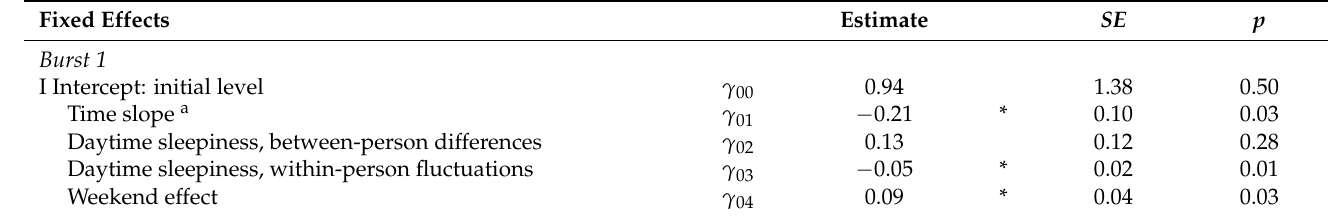
Table A4. Multilevel model to test the between- and within-person association between children’s daytime sleepiness and concurrent ADHD symptom